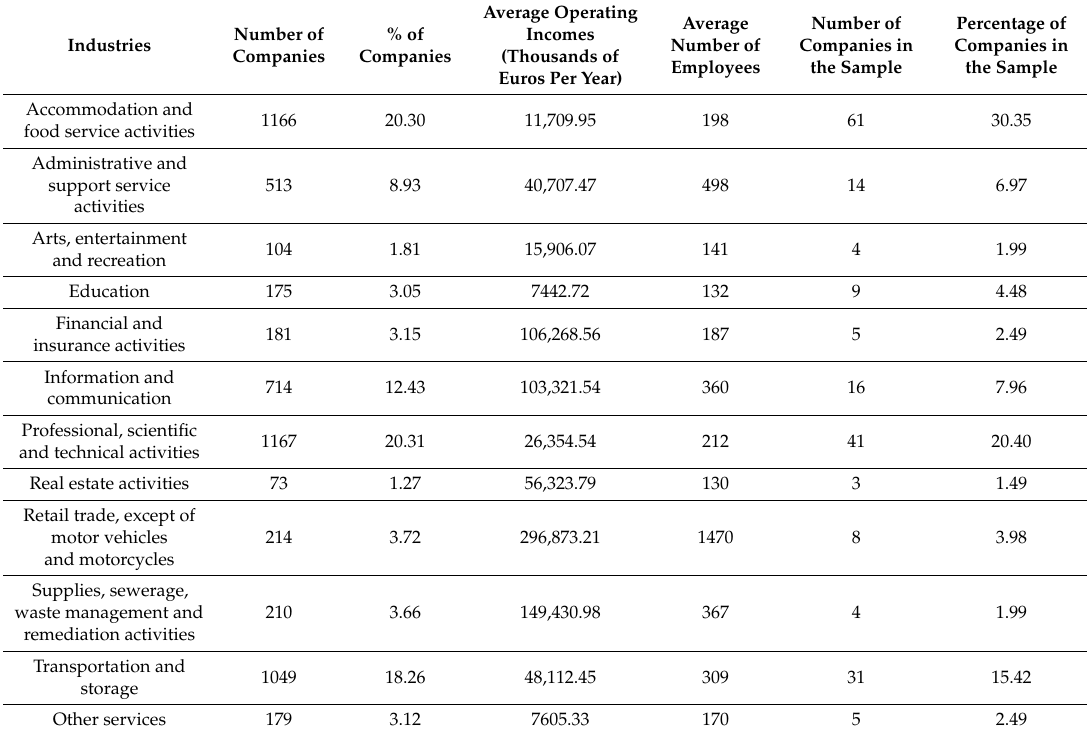
Table 1. Population and